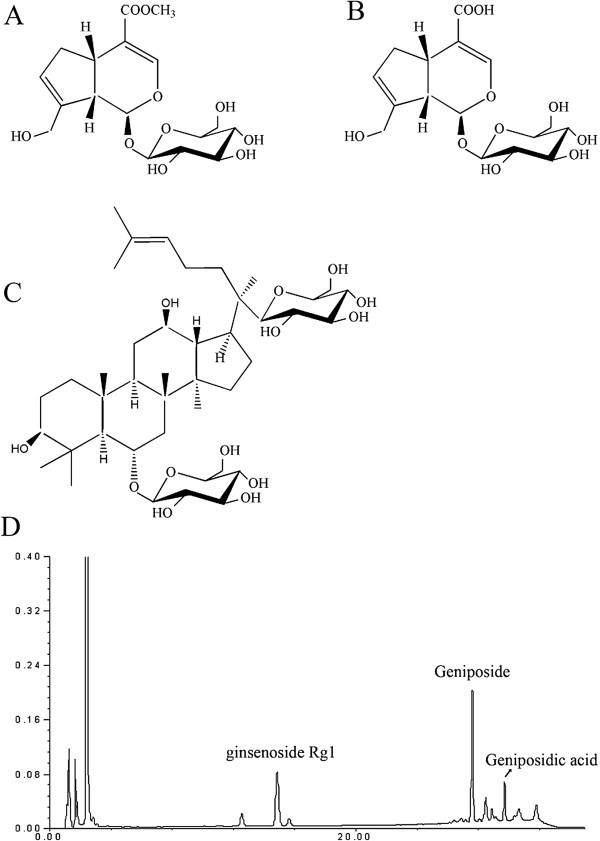
Chemical structures and HPLC analysis of TLJN. A. Geniposide (C16H24O10, molecular weight 388 Da); B. Geniposidic acid (C16H22O10, molecular weight 374 Da); C. Ginsenoside Rg1 (C42H72O14, molecular weight 800 Da); D. HPLC analysis of TLJN.